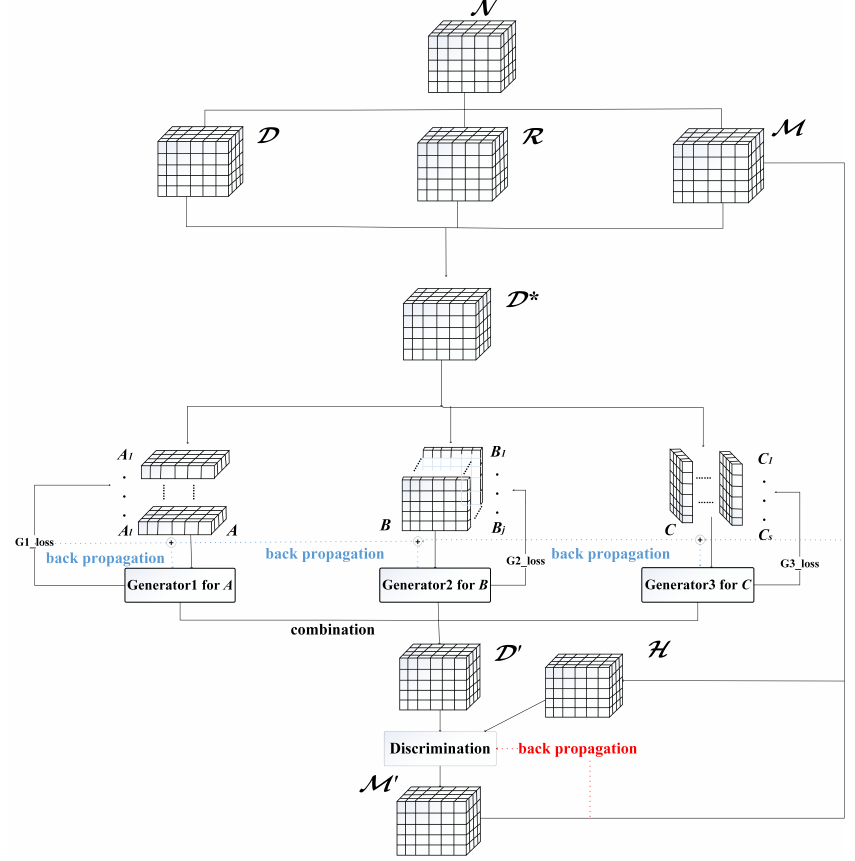
Figure 5. The architecture of ST-GAIN